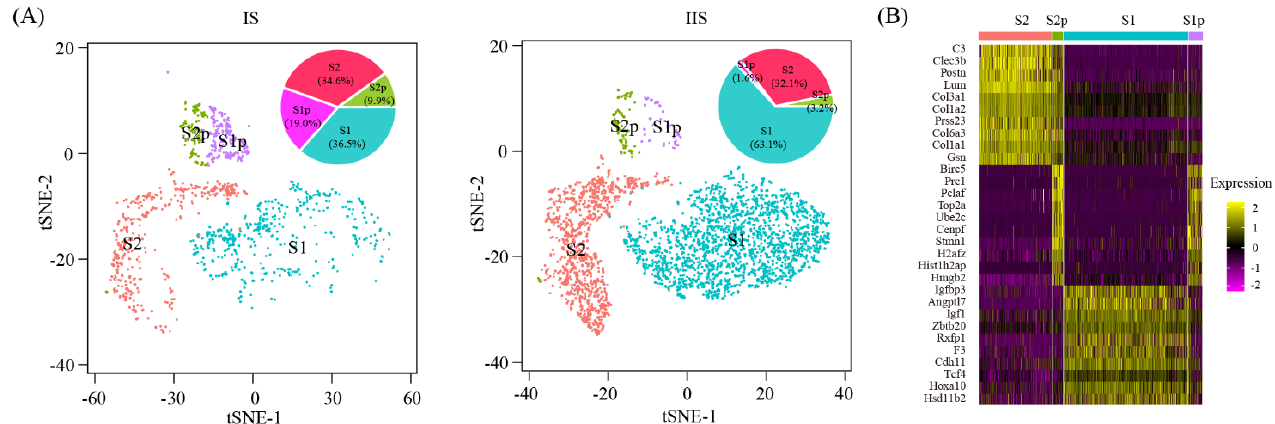
Figure 6. Sub-clusters of stromal cells: ( A ) TSNE plot showing four clusters of stromal cells. Relative cell type abundance was shown as insets; ( B ) heatmap of top 10 gene expression signatures for each cell type.